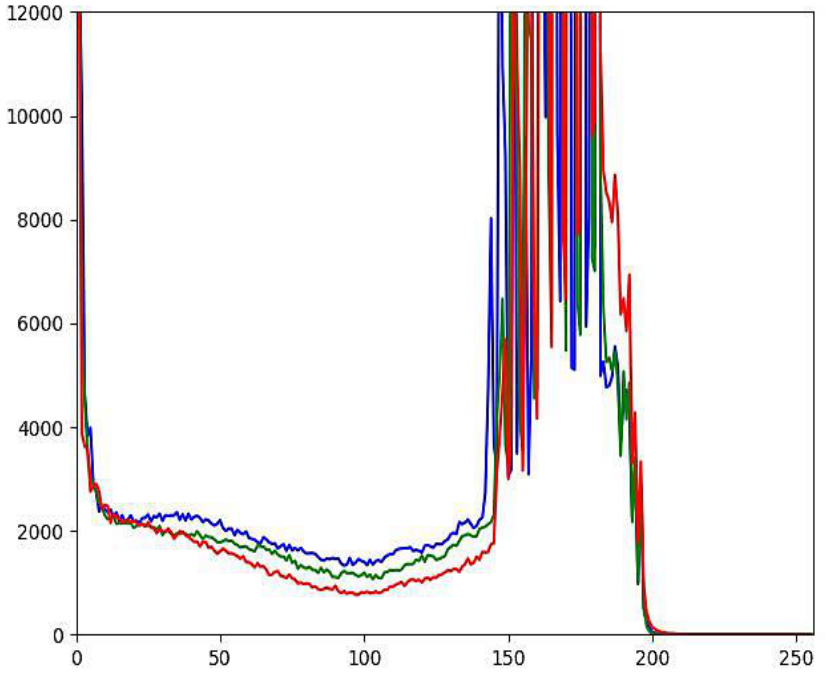
Figure 39. Histogram of RGB graph for the image (see Figure